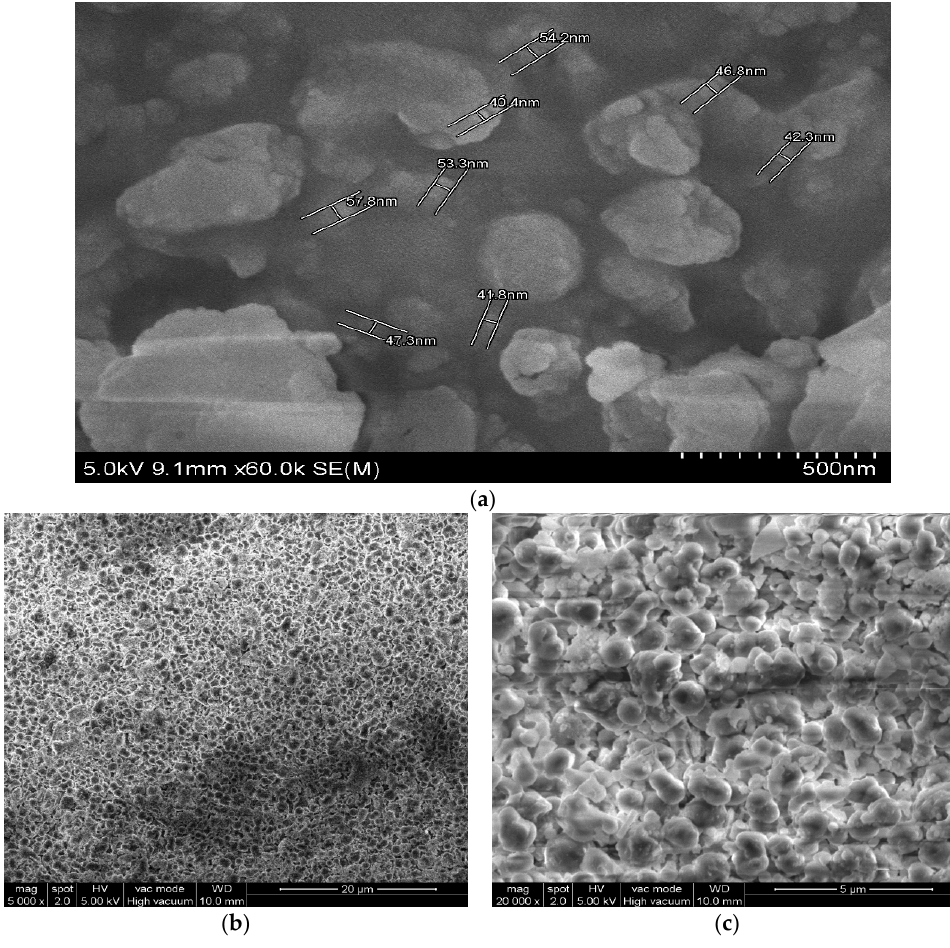
Figure 2. ( a ) Energy dispersive X-ray spectroscopy (EDS) spectrum for the region in Figure 1c , ( b ) EDS spectrum with peaks corresponding to bismuth.